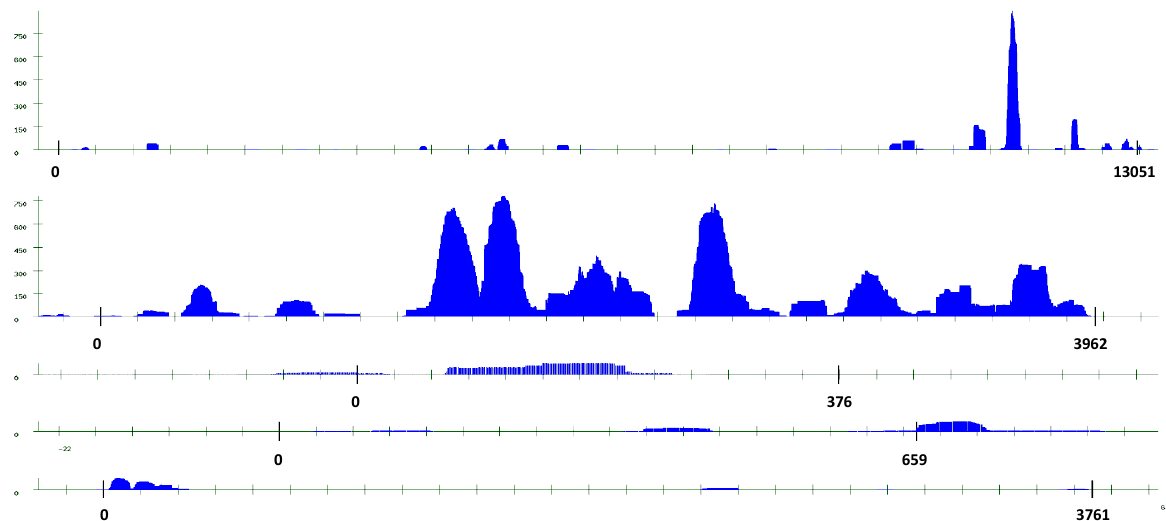
Figure 2. Fam_42_94_7. Examples of the different pattern of transcription in neurons; found in satellites with the same repeat sequence of 94 nt. The origin and end points are indicated for each satellite. Satellites in this family have very different lengths and very different expression patterns. One of the longest satellites we detected (37,806 nt) also belongs to this family. Due to its length, it is not presented here; a high resolution image is available in Supplementary Data 2. An additional satellite of this family (I: 10913365) is found in an intron of gene F49D11.4. This family corresponds to CeRep59 in the UCSC Genome Browser [13].